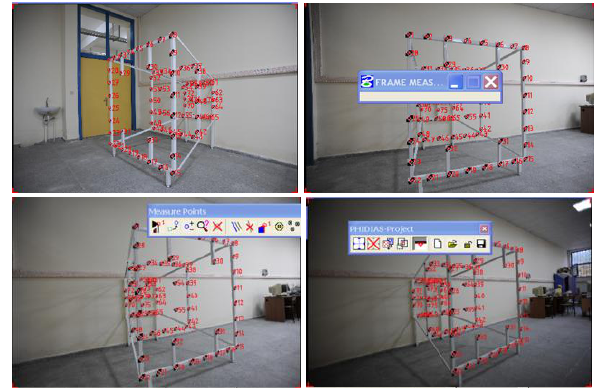
Figure 4. Control points measurements on the 3D test object with Nikon D3X SLR digital